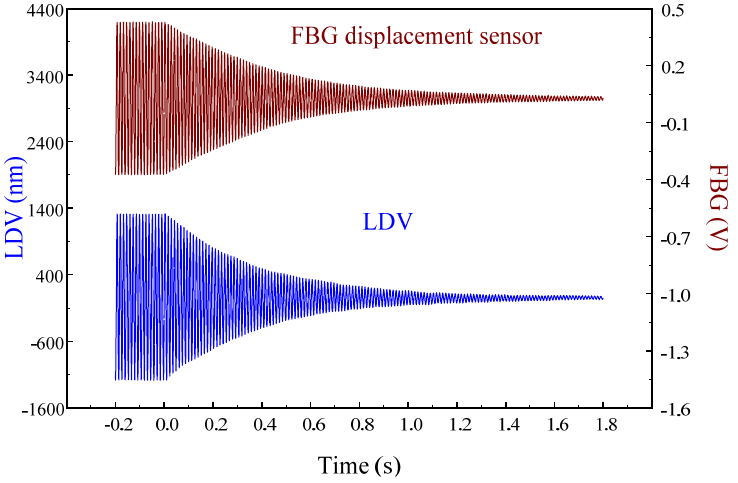
Figure 22. Free vibration of the smart cantilever beam excited at first resonant frequency (76 Hz) obtained from the FBG displacement sensor and